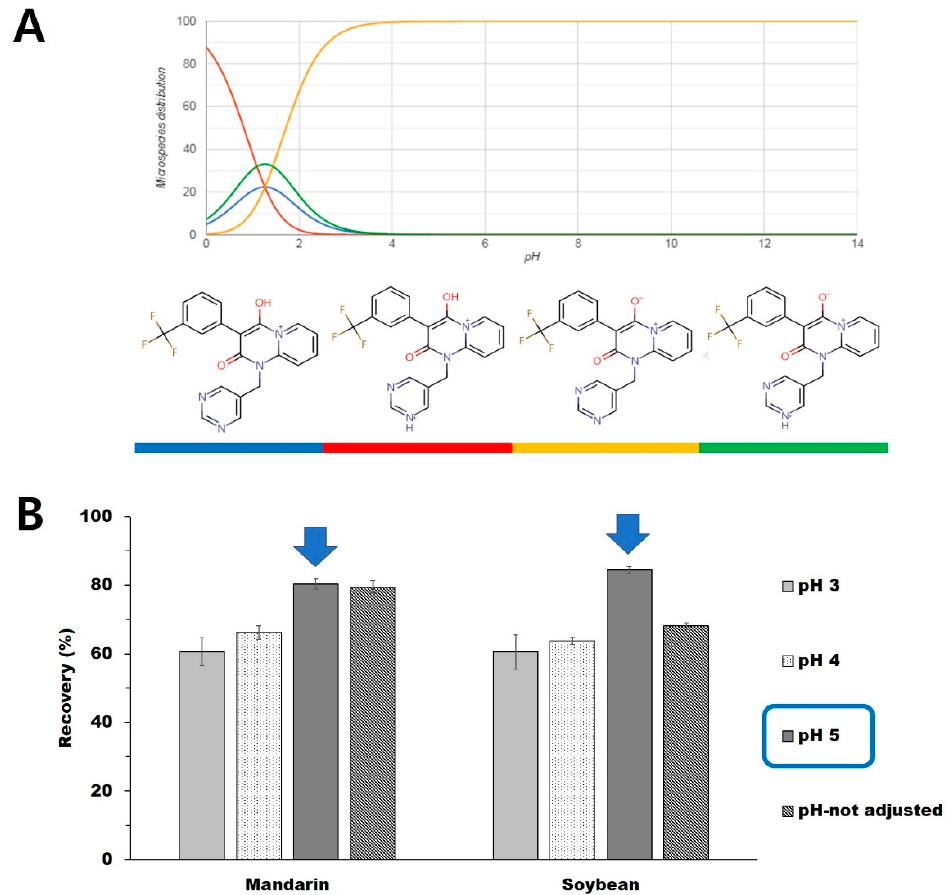
Figure 1. ( A ) pKa graph of triflumezopyrim and its molecular form at different pH value and ( B ) the effect of pH on extraction recovery in mandarin and soybean food matrices.